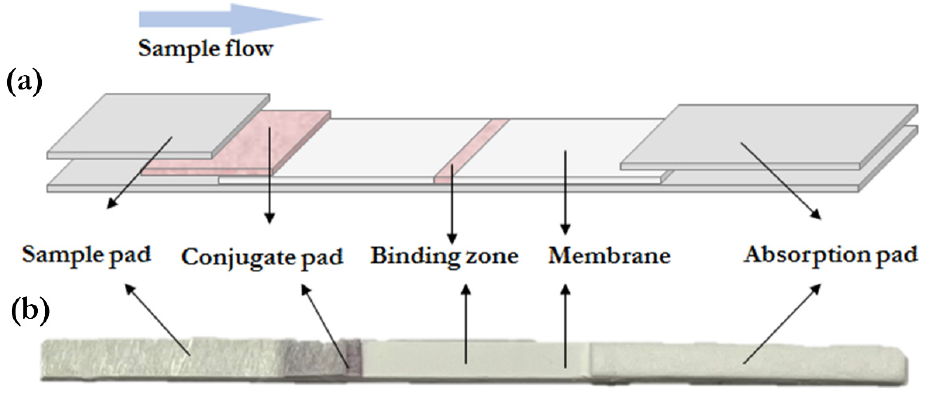
Scheme 1. Fabrication structure of lateral flow test strip, showing ( a ) schematic representation of the test strip and ( b ) photo of the prepared test